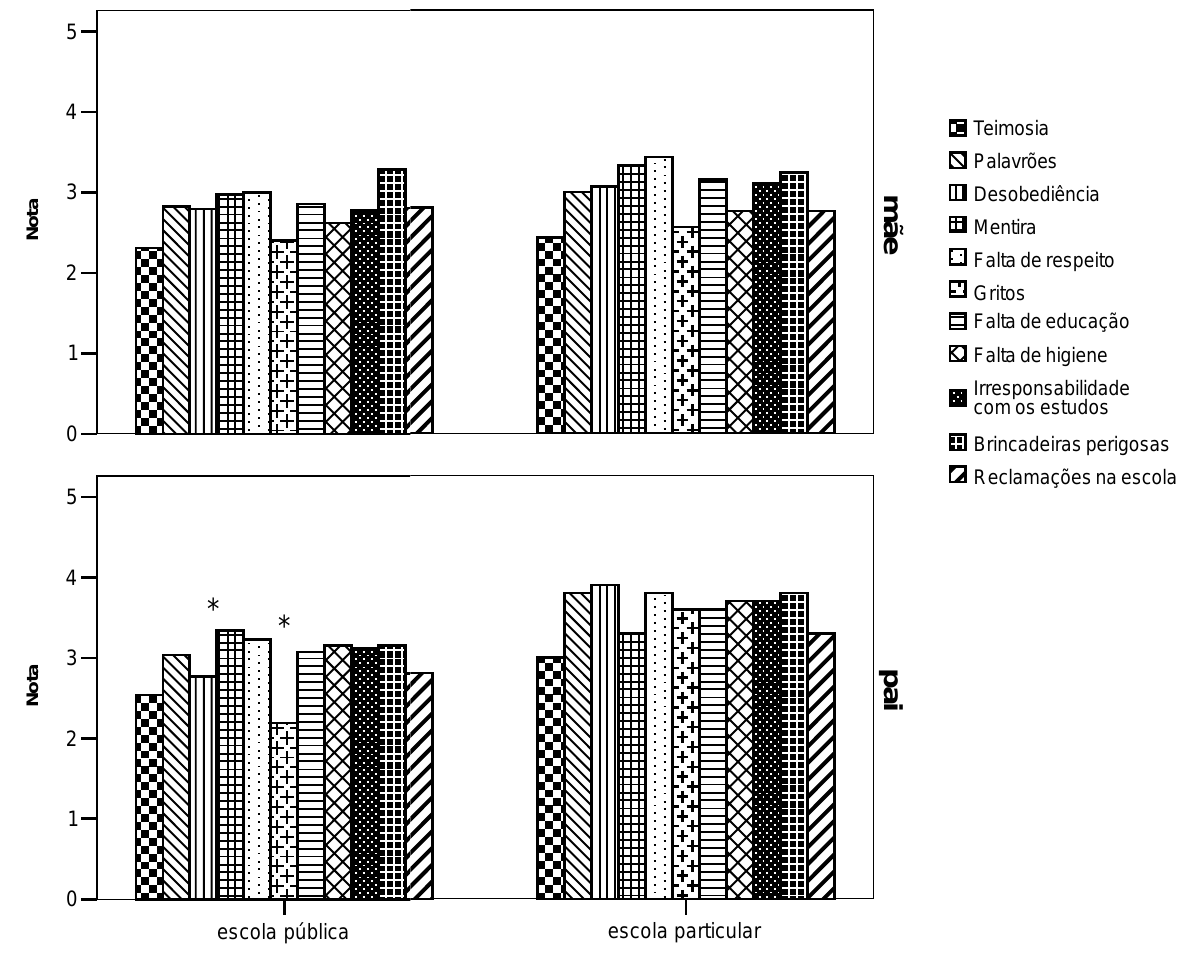
Figura 2. (1-nada grave, 2-pouco grave, 3-grave, 4-muito grave, 5-extremamente grave) atribuída por pais e mães de